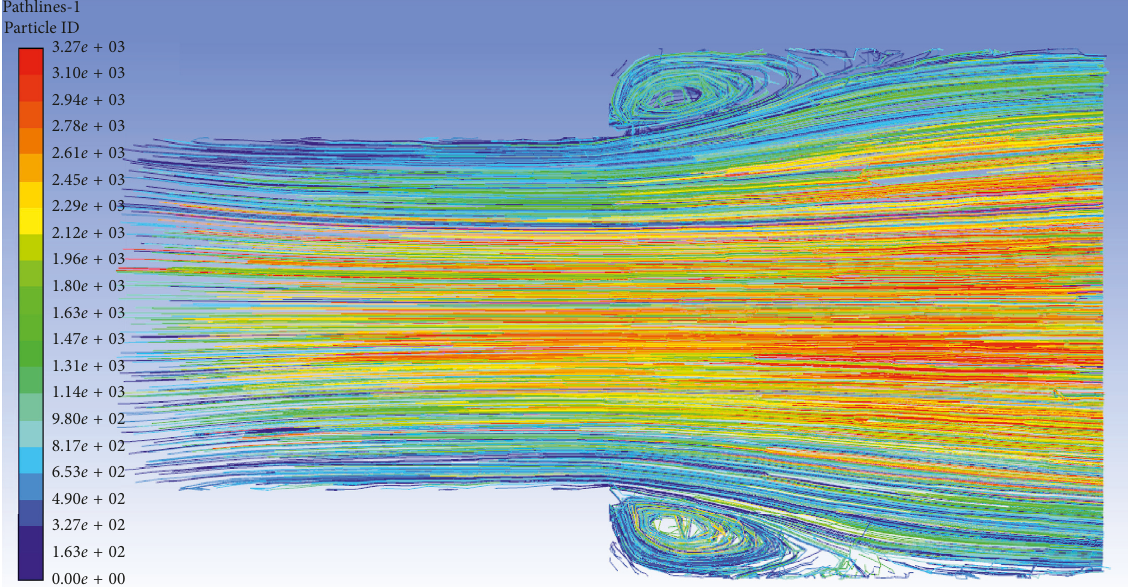
Figure 19: Without chamfer (sudden spread ratio is